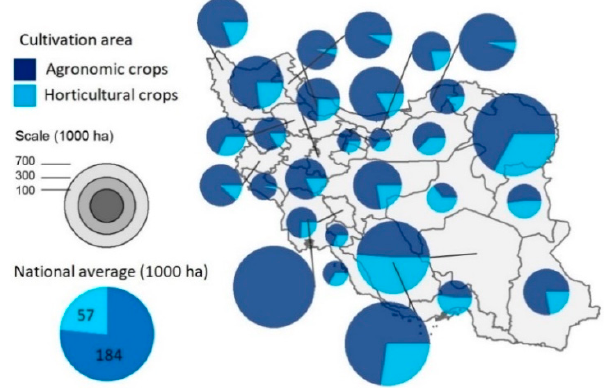
Figure 2. Province-level distribution of agronomic and horticultural crop acreages in Iran in 2015 (Sources of data: Ahmadi et al. [33,34]).